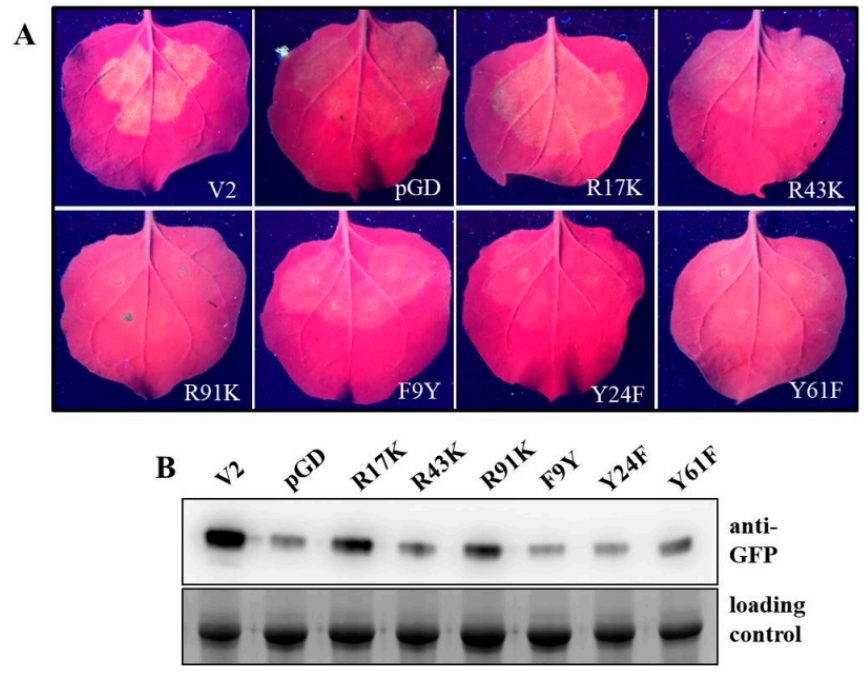
Figure 4. Silencing suppression activity of V2 mutants substituted with isomorphic amino acids. ( A ) Co-infiltration of wild-type N. benthamiana leaf patches with pGD-GFP and one of the substitution mutants of V2 including R17K, R43K, R91K, F9Y, Y24F and Y61F. Co-infiltration with pGD-GFP and pGD or pGD-V2 served as negative and positive control, respectively. Photographs were taken at 3 dpa. ( B ), Western blot analysis of the GFP protein accumulation in agroinfiltrated leaf patches with different constructs at 3 dpa. The Coomassie-blue-stained gel served as a loading